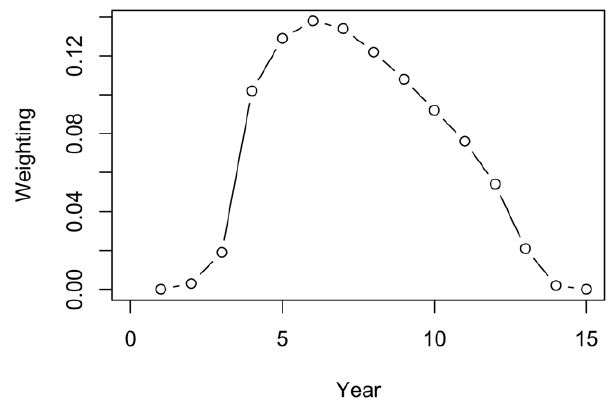
Figure 1. The assumed distribution of probability of detection in each year of a 15 year scrapie epidemic [ 30 ] .